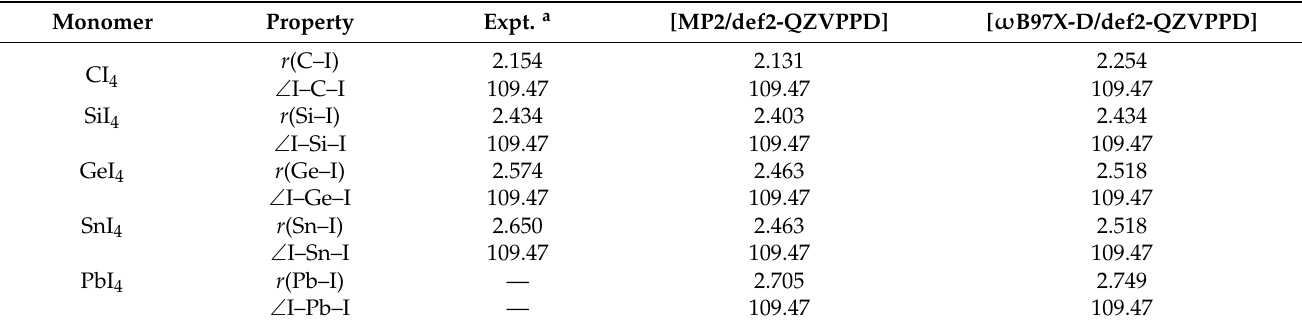
Table 1. Comparison of computed Tt–I bond distances r (Å) and I–Tt–I bond angles ∠ (degree) of TtI 4 (Tt = C, Si, Ge, Sn, and Pb) with those feasible in their corresponding crystals retrieved from the Inorganic Crystal Structure Database (ICSD) a .